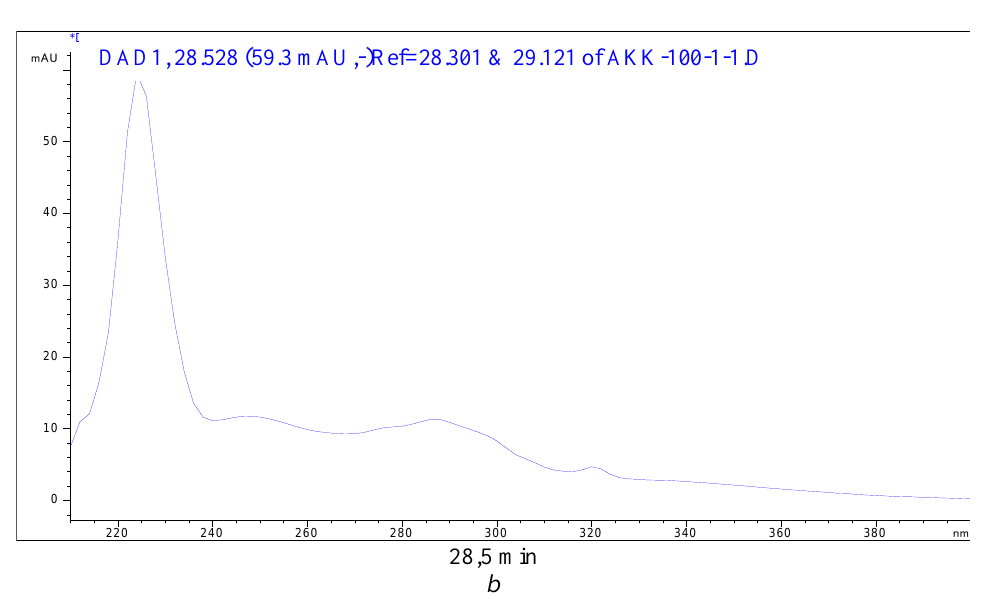
Fig. 5. UV spectra: а – dansyl chloride; b – aminocaproic acid